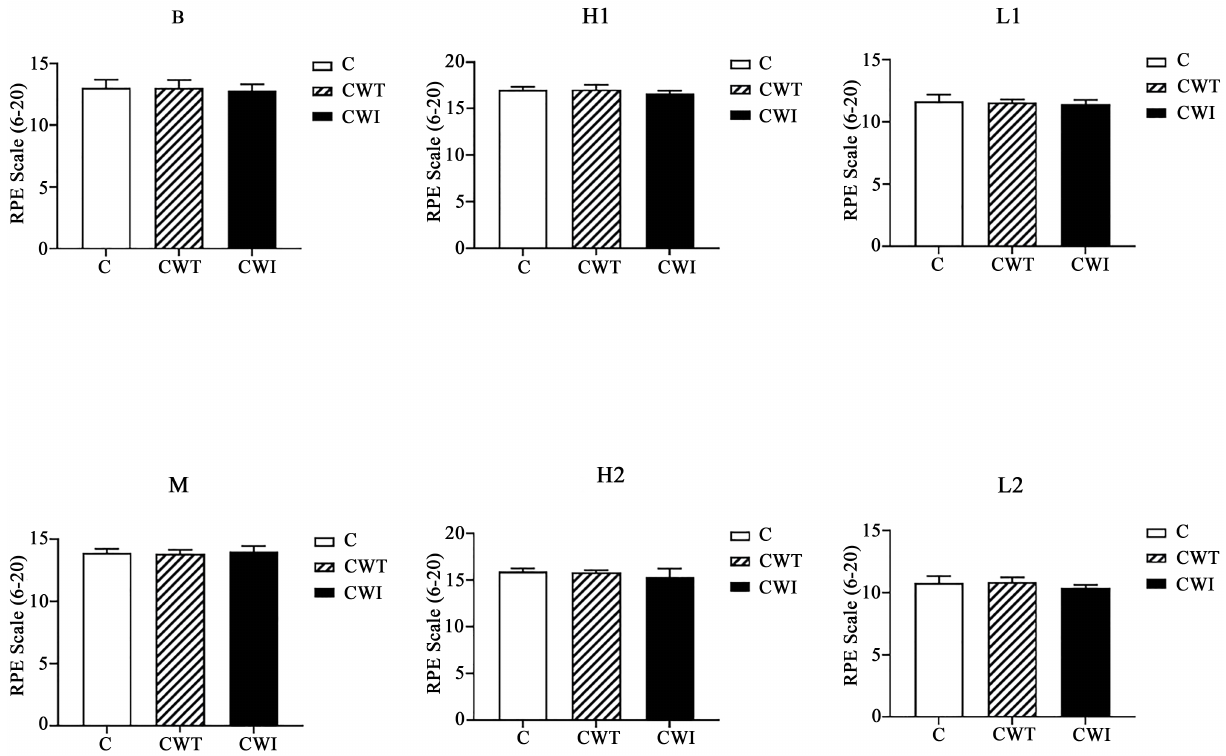
Fig. 4. RPE value at the 6 times point in three